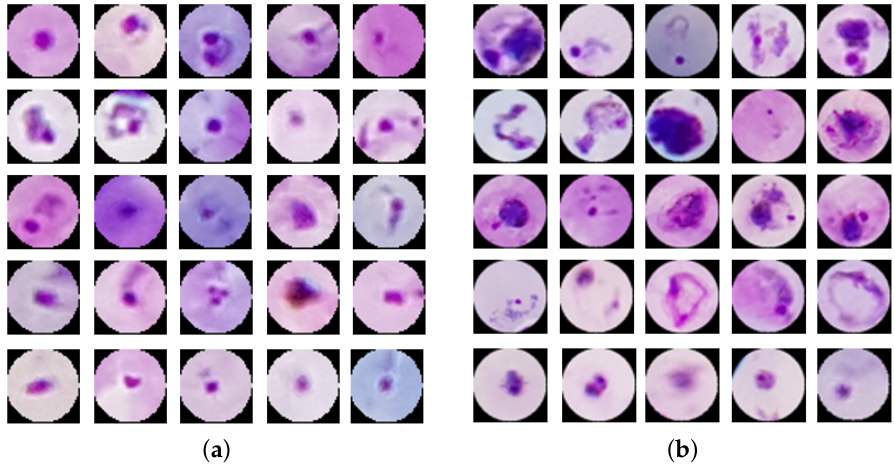
Figure 1. Examples of P. vivax and P. falciparum parasites. We extract those samples using the gold standard ground truth annotated by an expert reader. We resize the parasites to 44 × 44 for better visualization and consistency. ( a ) P. falciparum parasites. ( b ) P. vivax